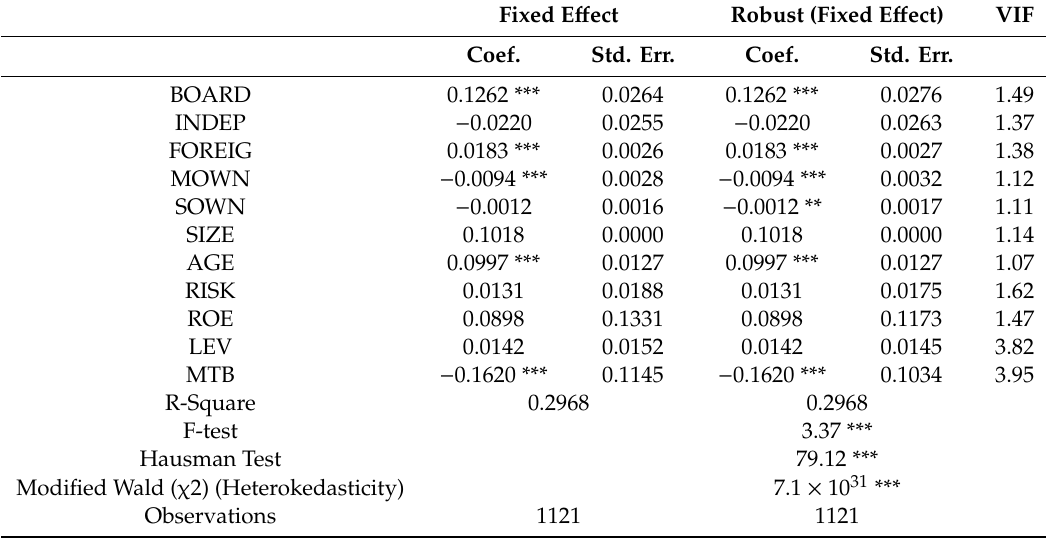
Table 5. Regression